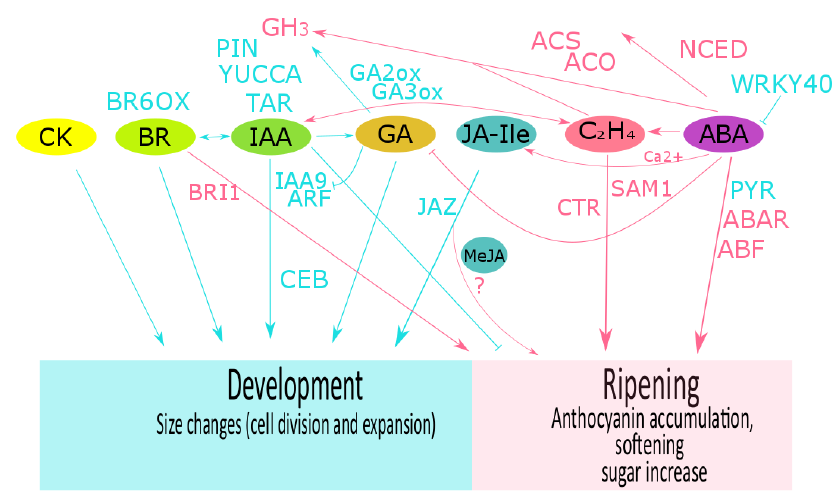
Figure 2. Phytohormone crosstalk described in grape, strawberry and raspberry fruits. The role of hormones and their related components during fruit development (cyan color) and during ripening (pink color) are shown for abscisic acid (ABA), auxin (IAA), ethylene (C 2 H 4 ), brassinosteroids (BR), gibberellins (GA), cytokinins (CK), and jasmonic acid isoleucine conjugate (JA-Ile). In many fruits, development is controlled by a balance between GA and auxin. In grape, GA downregulates VvIAA9 and VvARF7 expression and then auxin transport, and upregulates VvGH3 expression. In turn, auxins could promote fruit set and biosynthesis of gibberellins. IAA and BRs crosstalk has been suggesting as an important mechanism to control fruit growth. During grape ripening, an interaction between ethylene and auxin has been described, and calcium-ABA-JA interplay could regulate the expression of flavonoid biosynthesis. In strawberry, ABA, auxin and GA crosstalk regulate the transition of development to ripening. Methyl jasmonate (MeJA) application at the onset of ripening stimulates ethylene and anthocyanin biosynthesis. However, the JA-Ile content has been suggested as important for fruit development. FaNCED1 downregulation by MeJA application suggests an antagonistic role of JA on ABA biosynthesis. In raspberry, exogenous IAA and MeJA regulate the anthocyanin content. TAR: tryptophan aminotransferase; YUCCA: flavin-containing monooxygenases; PIN: auxin transporter (PIN-FORMED protein); GH3: IAA-amido synthetase; ARF: auxin response factor; CEB1: transcriptional factor cell elongation bHLH protein; NCED: 9- cis -epoxycarotenoid dioxygenase; PYR1: